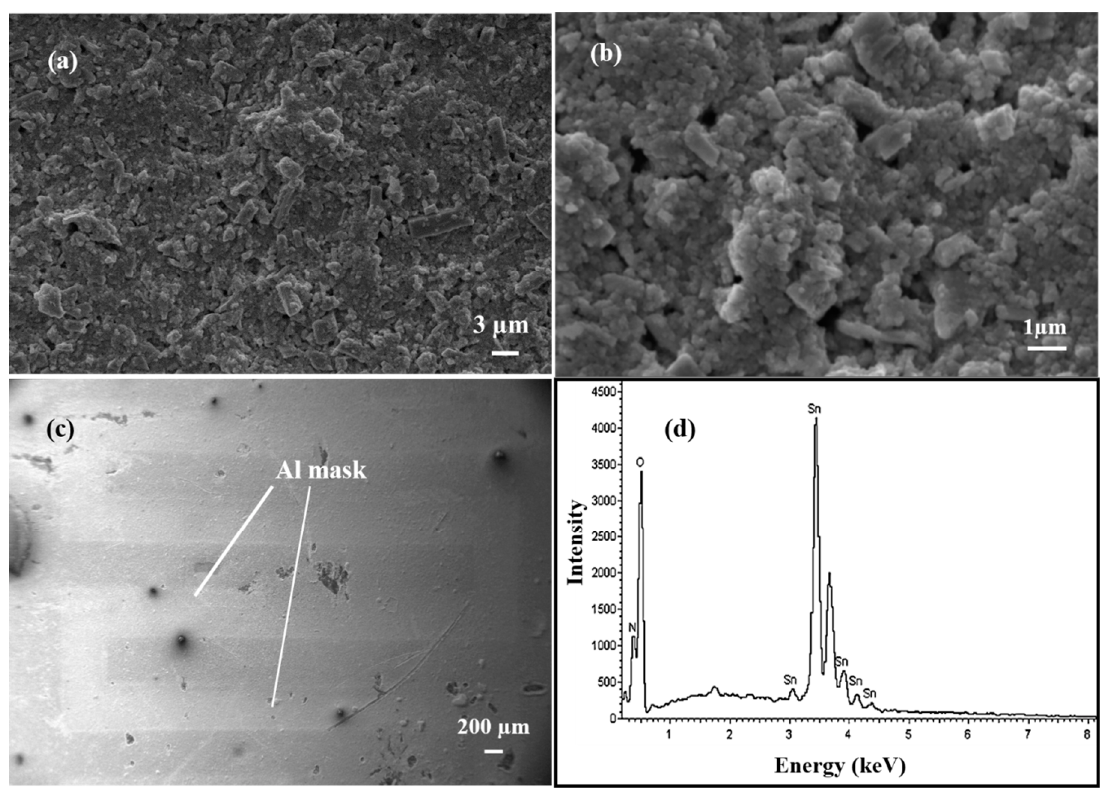
Figure 3. ( a – c ) 6 SEM image of the SnO 2 thin film at different magnifications. ( d ) EDS of the tin oxide film.